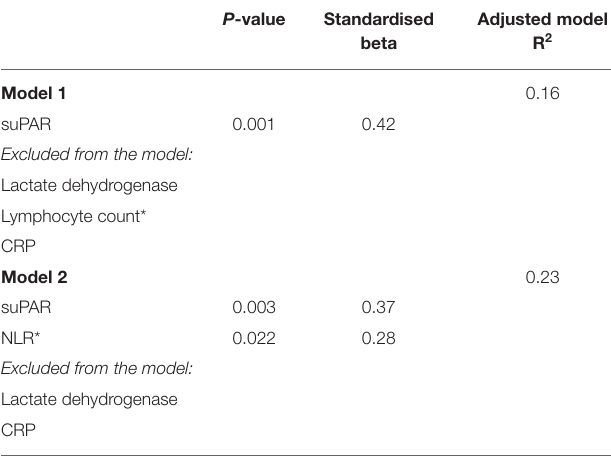
TABLE 2 | Biochemical variables associated with length of hospital stay (10log) in stepwise linear regression analyses.